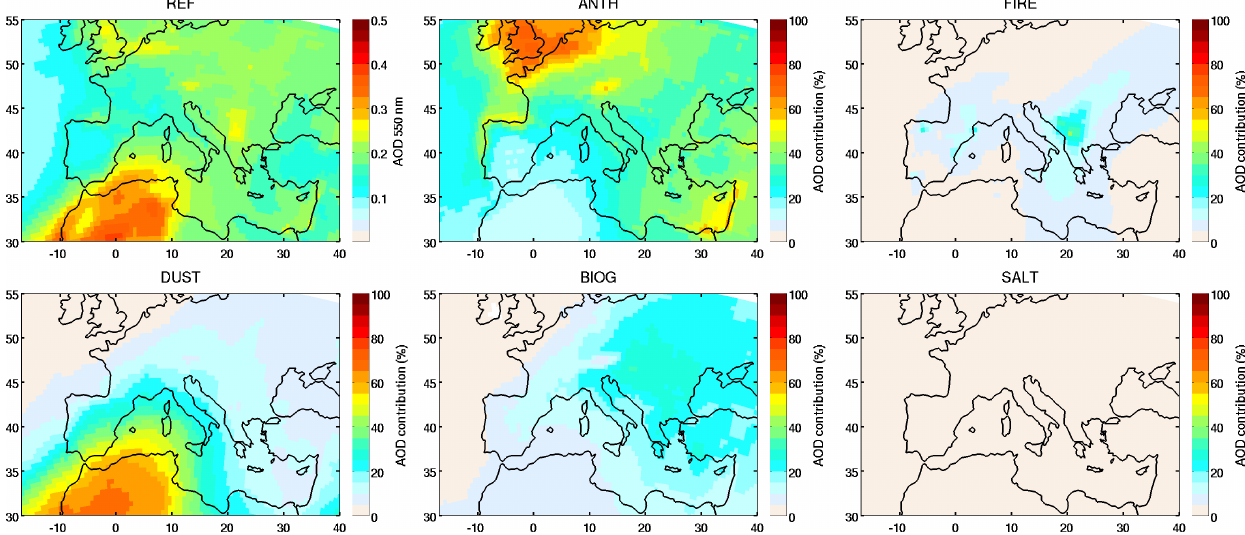
Figure 10. Relative contribution of each source type (i.e., the baseline simulation minus the sensitivity simulation where the respective source has been eliminated) to the simulated AOD at 550nm, averaged over the period (1 June to 31 August 2012). The top left represents the reference simulation of AOD over the same